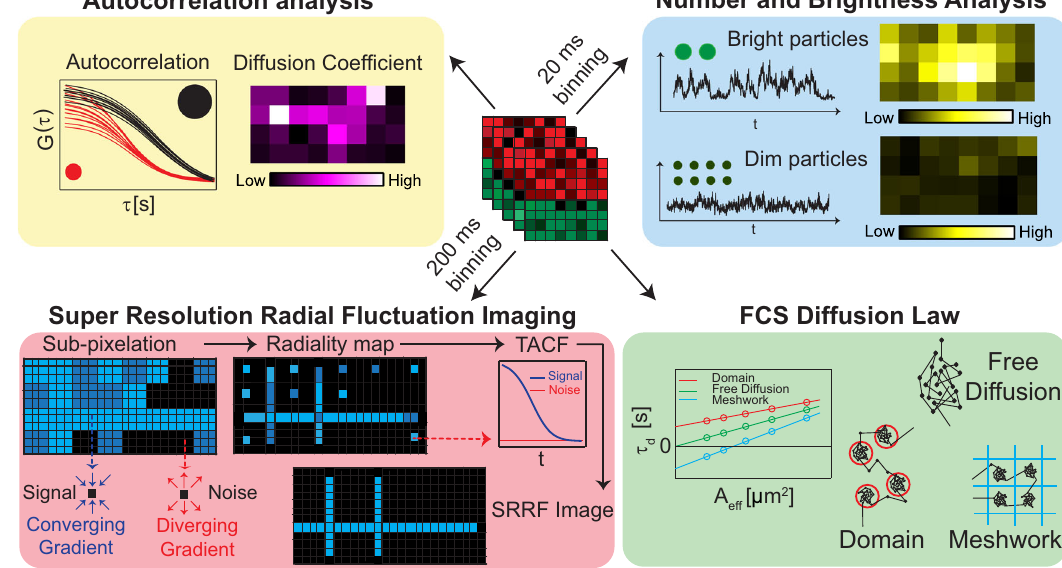
Fig. 1 Simultaneous spatiotemporal super-resolution and multi-parametric fl uorescence microscopy from a single fl uorescence data set. The various analyses performed on a single fl uorescence data set are shown here: autocorrelation analysis to determine diffusion coef fi cient (top left), number and brightness analysis to determine particle brightness (top right), super-resolution radial fl uctuations imaging to resolve structures (bottom left), and FCS diffusion law to determine sub-resolution protein organization (bottom